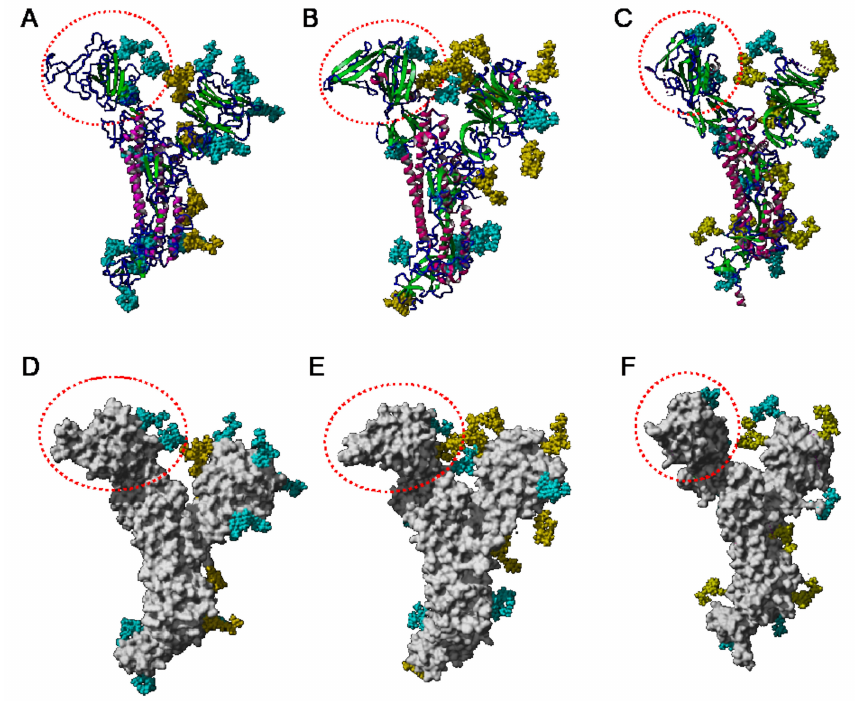
Figure 27. ( A – C ). Lateral face of the ribbon diagram representing the heavily glycosylated S glyco- protein of SARS-CoV (PDB code 6ACD) ( A ), MERS-CoV (PDB code 5W9H) ( B ), and SARS-CoV-2 (PDB code 6VXX) ( C ). High-mannose glycans and complex glycans are colored yellow and cyan, respectively. The RBD is indicated by a red dashed circle. ( D – F ). Lateral face of the molecular surface (colored grey) of the S-glycoprotein of SARS-CoV ( D ), MERS-CoV ( E ), and SARS-CoV-2 ( F ). High-mannose glycans and complex glycans are colored yellow and cyan,